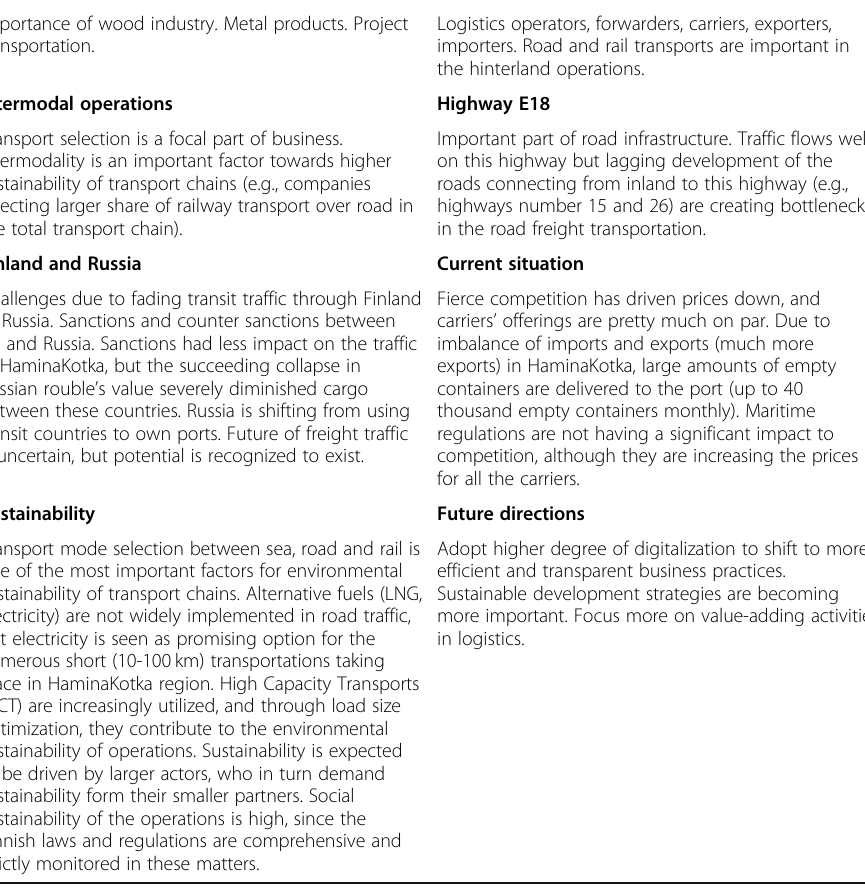
Table 2 Overview of the topics emerged in the interviews Types of handled